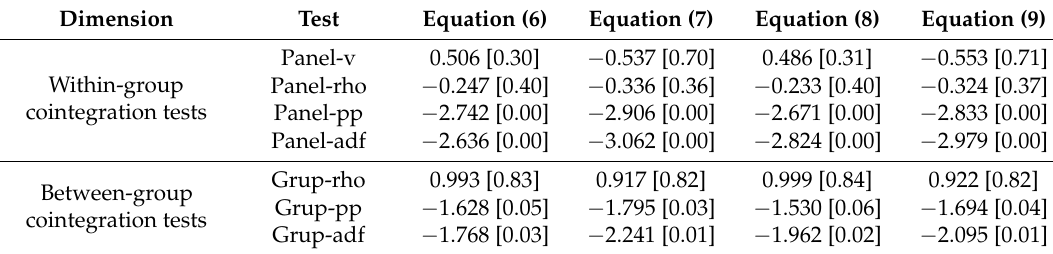
Table 5. Pedroni’s cointegration